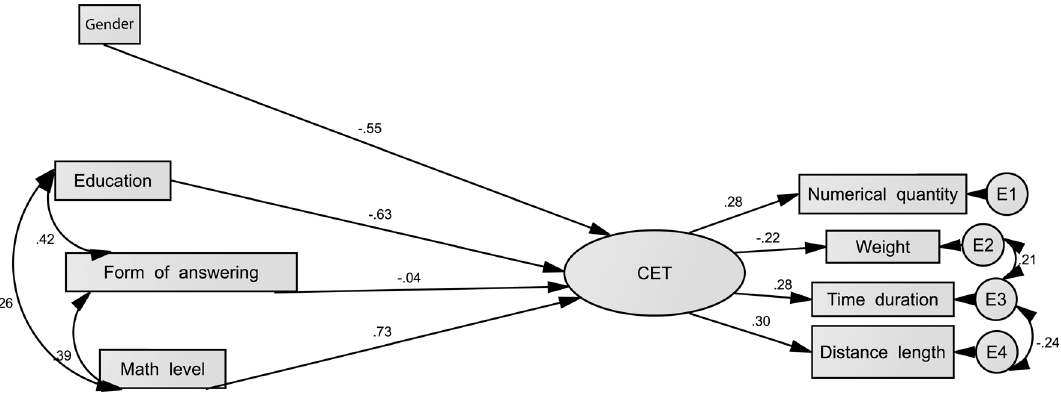
Figure 2. SEM model based on the improvement of the initial model described in Figure 1. Note. The result indicated that gender, education, and math level predicted estimation performance. Form of answering did not. All the values are